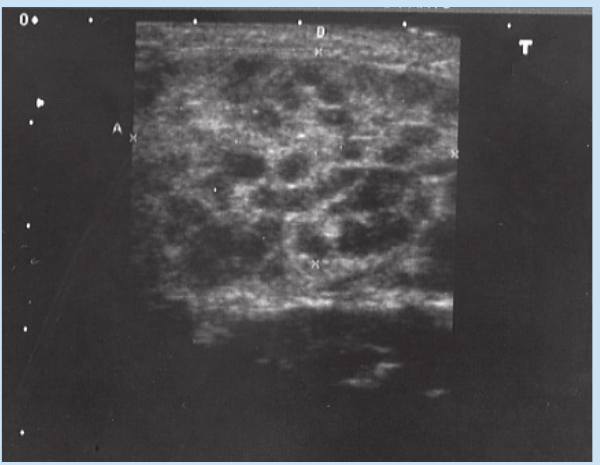
Fig. 1. Ultrasound: Multiple sonolucent areas representing lymphoepithelial cysts.